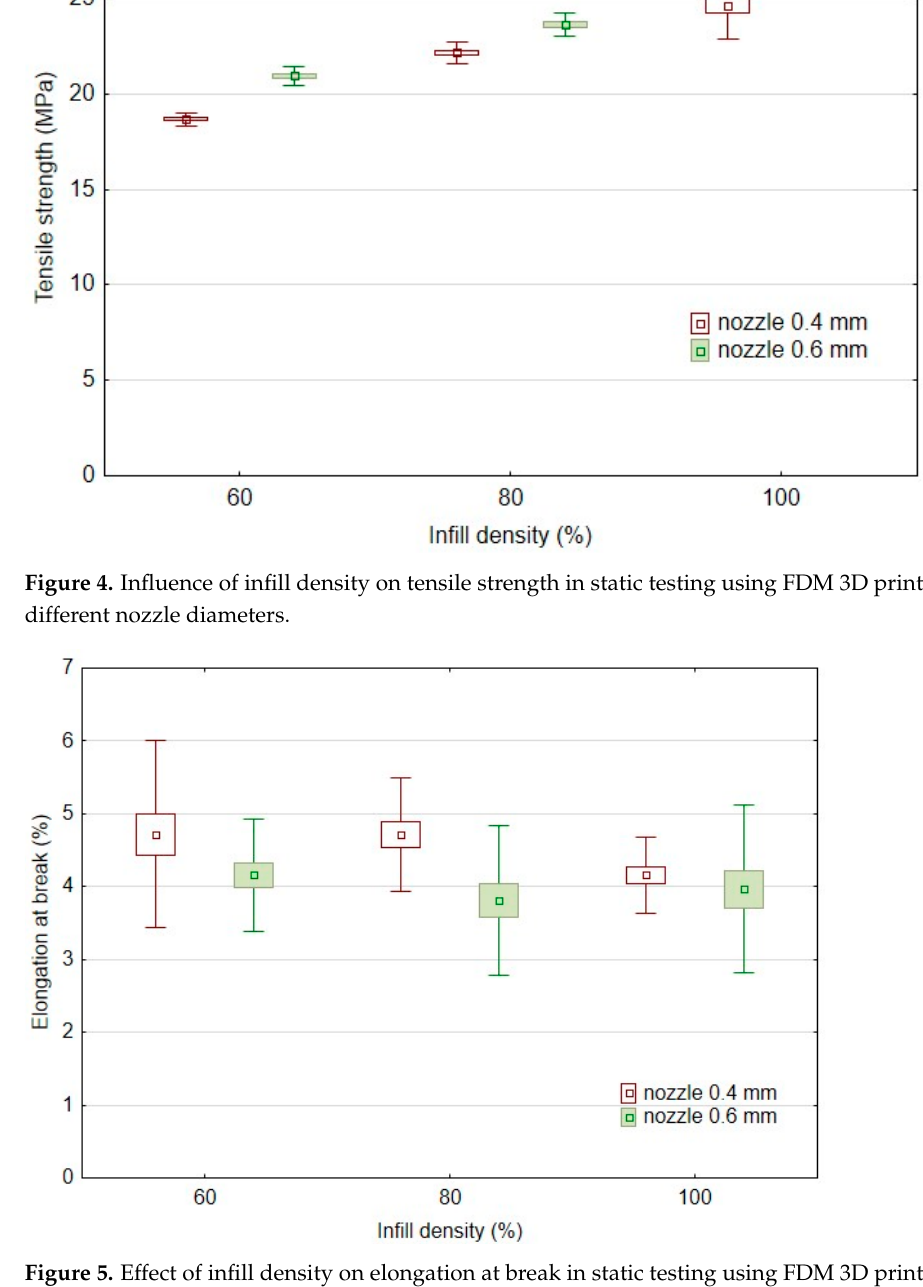
Figure 5. Effect of infill density on elongation at break in static testing using FDM 3D printing with different nozzle diameters.